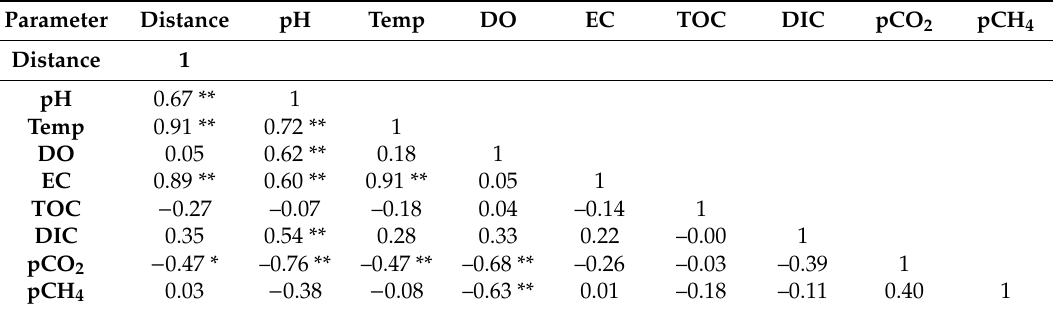
Table 2. Spearman’s rank correlation coe ffi cients between the measured variables at sampling stations along the Cauvery River basin during January 2016. Distance refers to the distance from the